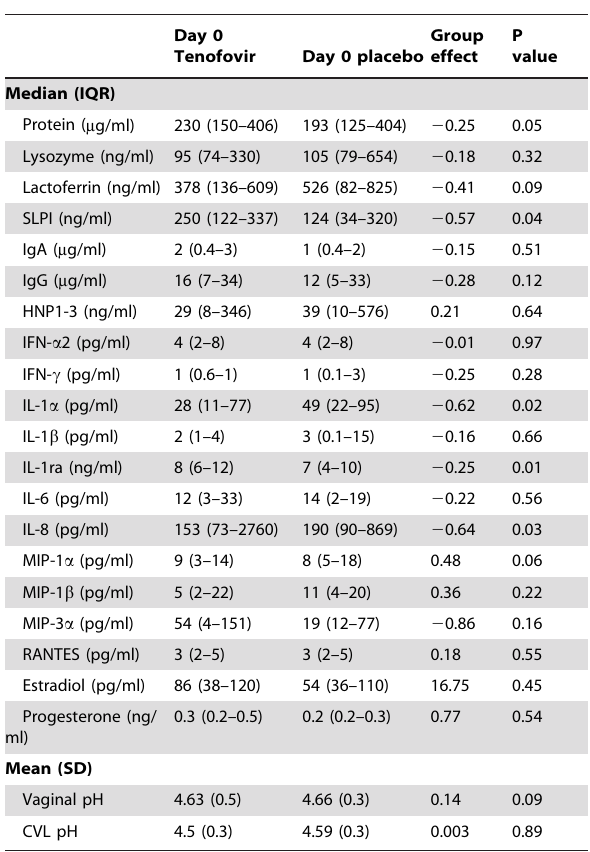
Table 3. Summary of Day 0 concentrations of soluble immune mediators and pH and comparison of changes in levels between TFV and placebo